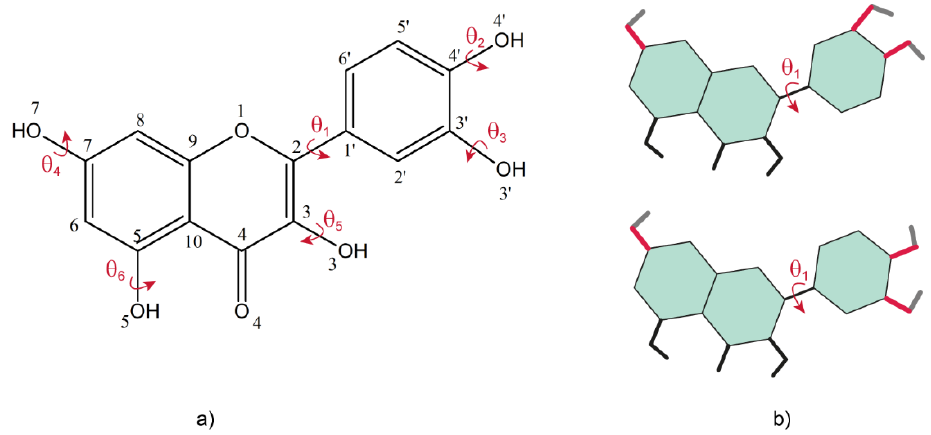
Figure 7. ( a ) The chemical structure of Quercetin, which emphasizes the flexible torsion angles considered for structure determination, including DFT geometry optimization; ( b ) the two distinct relative conformations of the catechol and benzopyran rings found in all the reported solid forms of Quercetin, close to syn—bottom, and close to anti—up.